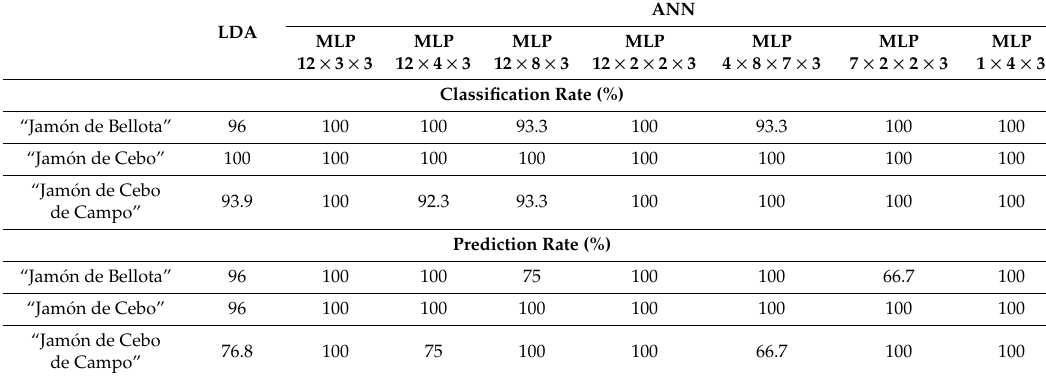
Table 3. Statistical performance for linear discriminant analysis (LDA) and artificial neural network (ANN) classification methods.